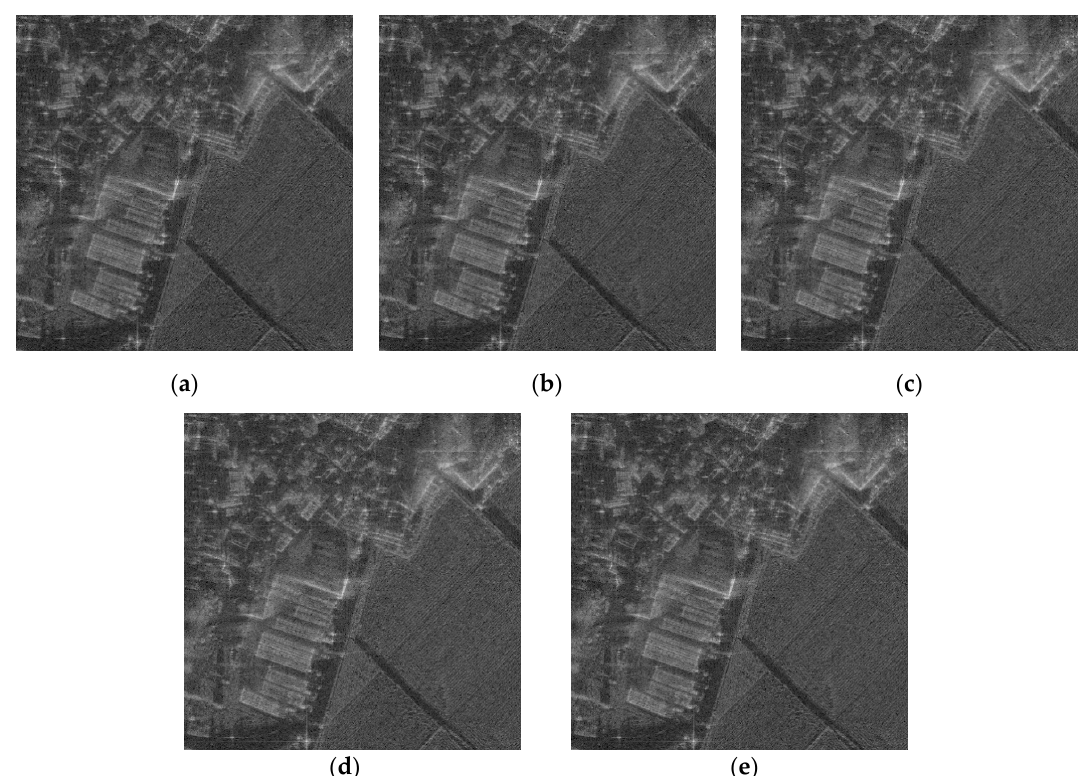
Figure 4. SAR image corrected by proposed FPA with the threshold set at ( a ) 0.01, ( b ) 0.1, ( c ) 0.3, ( d ) 0.9, ( e ) varying.